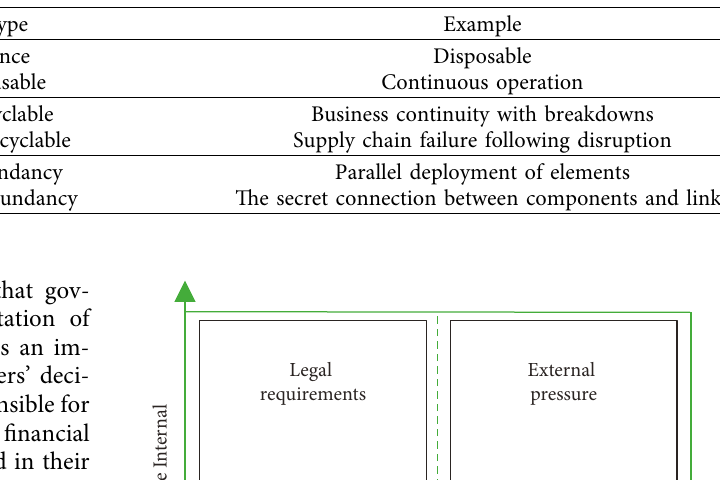
Table 3: Types of RSCs [60].